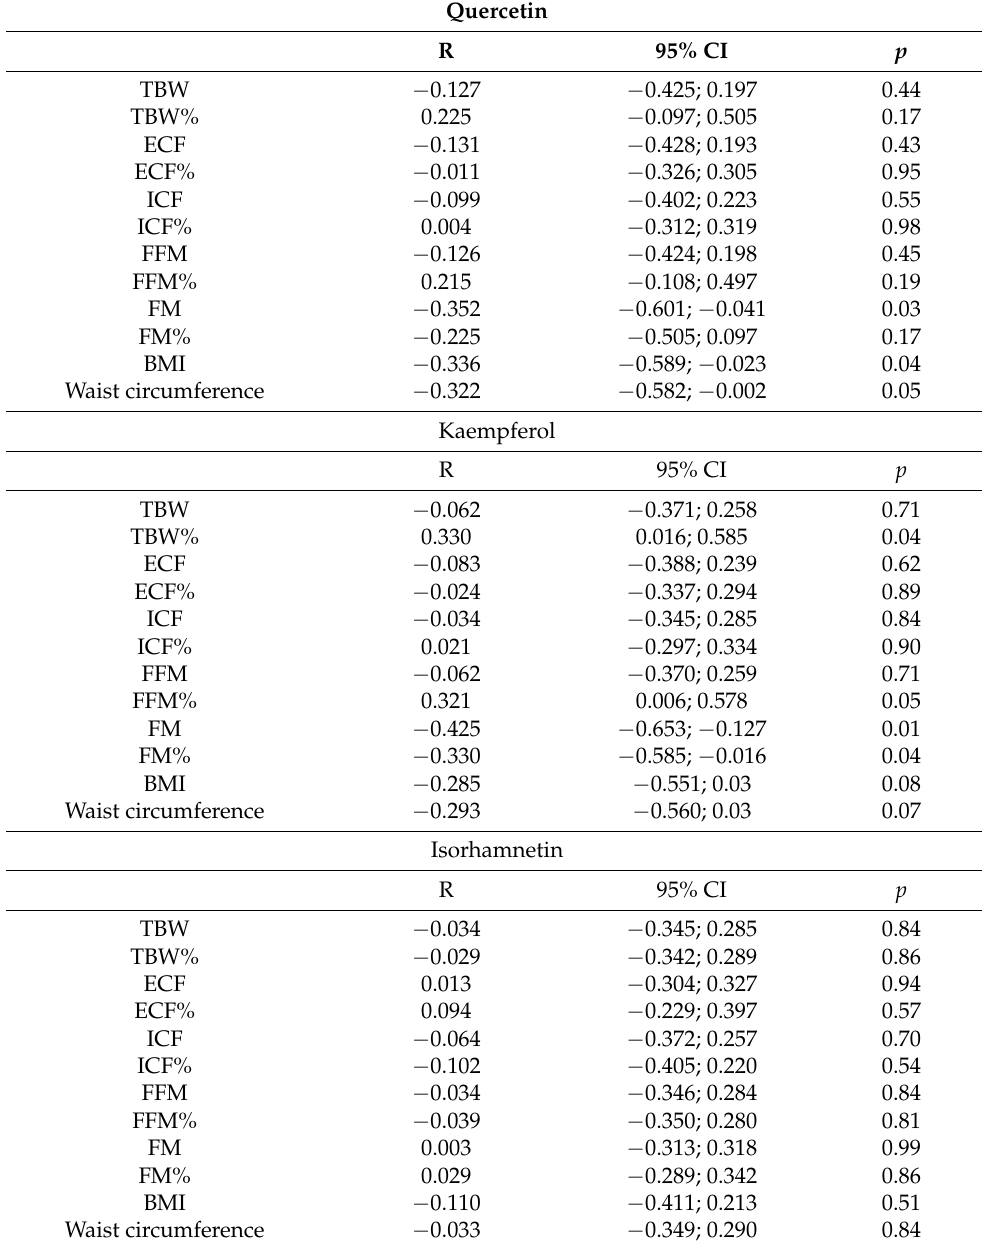
Table 4. Correlation between flavonol intake and BIA parameters, BMI and waist